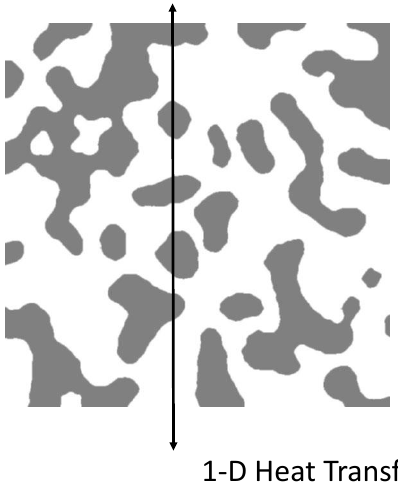
Figure 3. Test line through a snow surface section showing 1-D heat and mass transfer at the